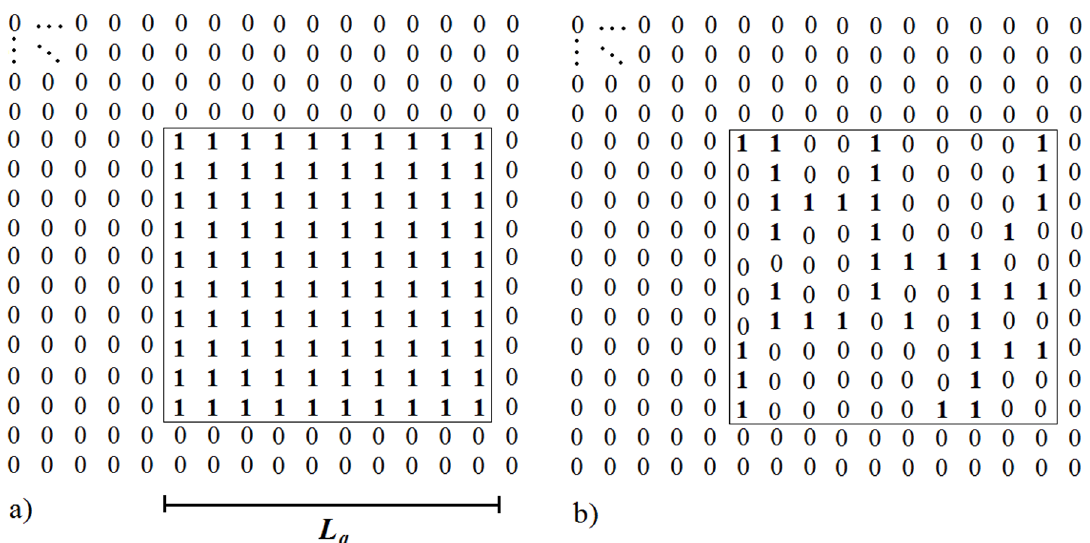
Figure 7. Scheme of volumetric representation of CB aggregate in the matrix: (a) aggregate in the simulator perspective; (b) aggregate after applying α correction factor.